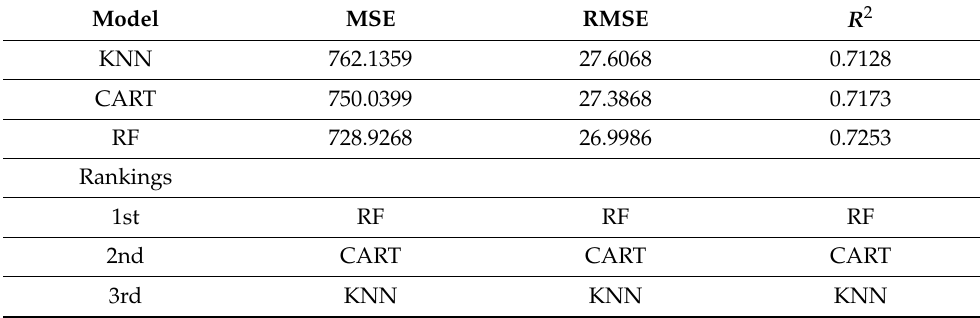
Table 15. The generalization performance and ranking of optimal KNN, CART, and RF